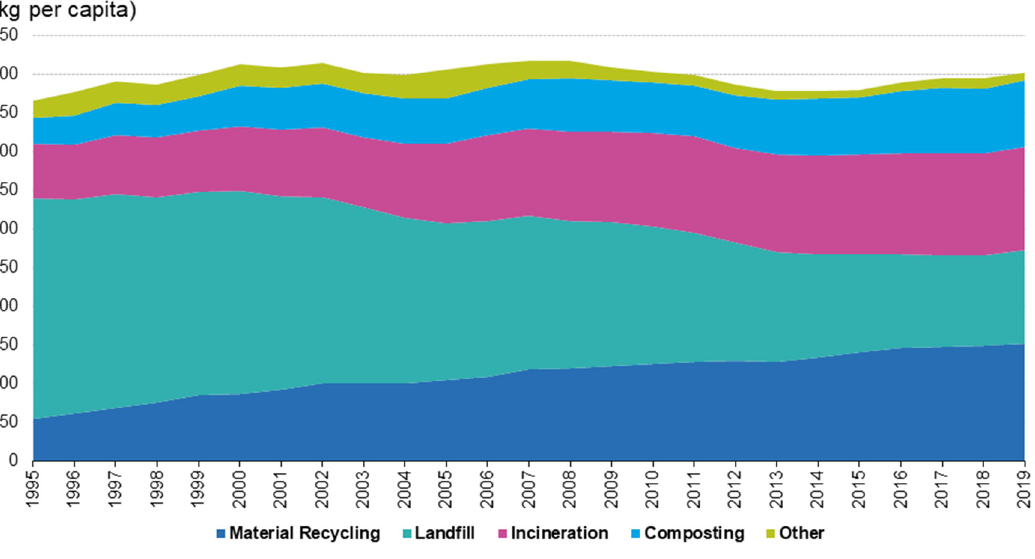
Figure 2. Municipal waste treatment, EU-27, 1995–2019. Source: Eurostat [7].